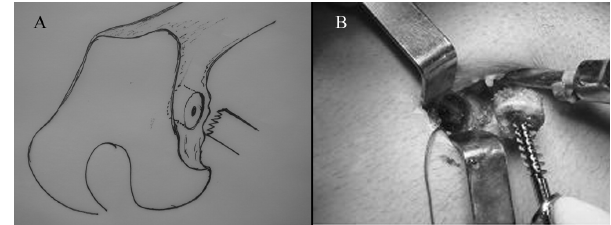
Figure 1 - (A) Cutting of the bone washer with a special trephine parallel to the growth plate. (B) Removal of the bone washer with the spongious screw.